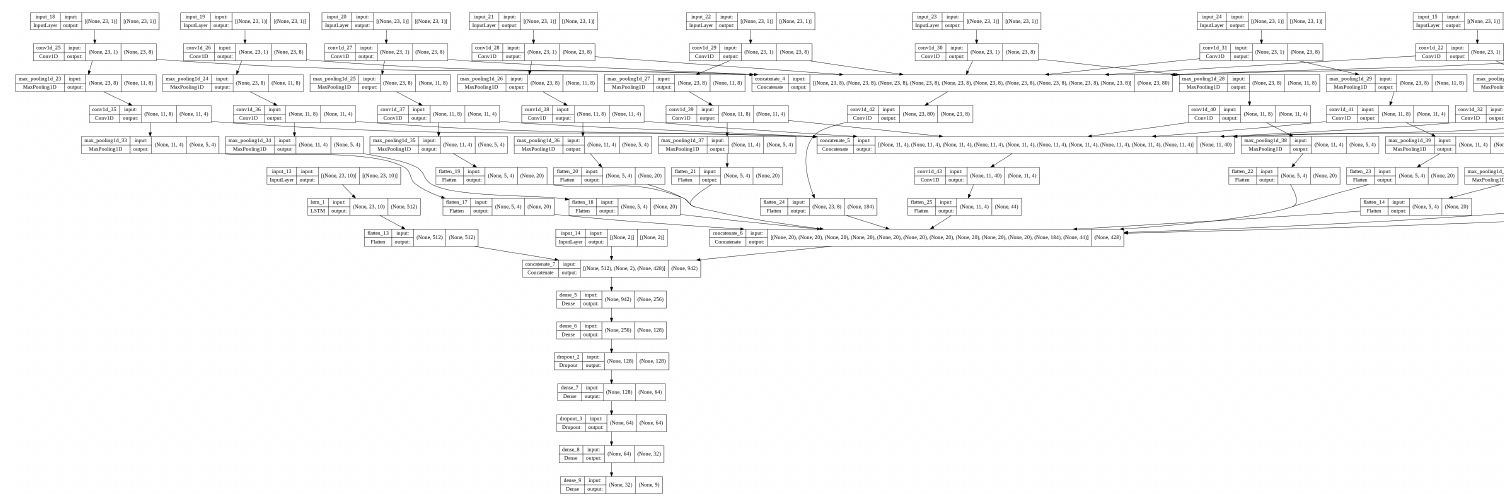
Figure A8. Univariate + multivariate (LSTM) +